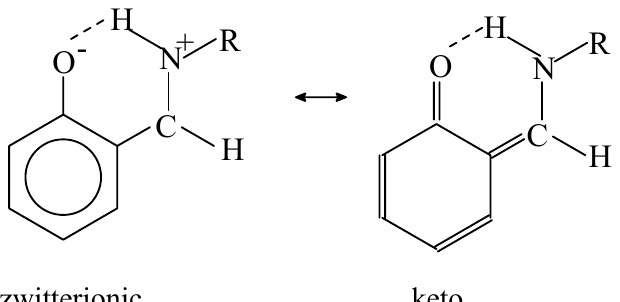
, 2 – CH Cl , 3 – CH OH (upper picture) and temperature; 4 2 2 3